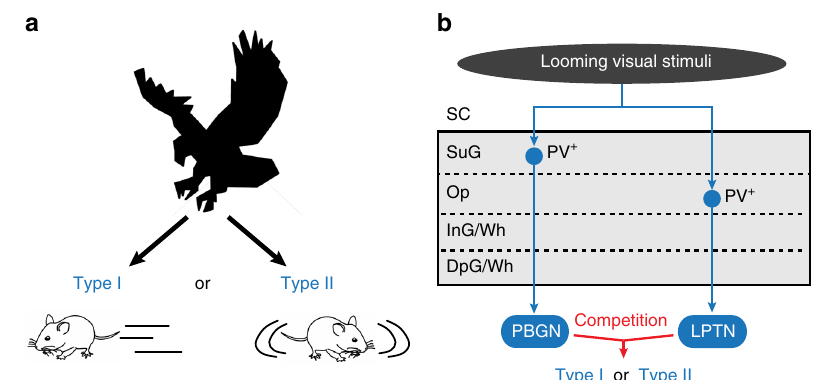
Fig. 10 Summarized diagram illustrating the circuit mechanism underlying the action selection between dimorphic defensive behaviors. a Looming visual stimuli mimicking predator of mice trigger either Type I (escape-freezing) or Type II (freezing-only) defensive behavioral pattern. b Looming visual stimuli were encoded by PV + neurons in retinal-recipient layers (SuG and Op) of the SC. Distinct groups of SC PV + neurons transmit looming visual signals to the PBGN and LPTN. PBGN and LPTN then send these signals to the downstream targets to determine the behavioral outcome of mice, either Type I or Type II defensive behavioral show distinct behavioral patterns to the same looming visual stimuli 5 .